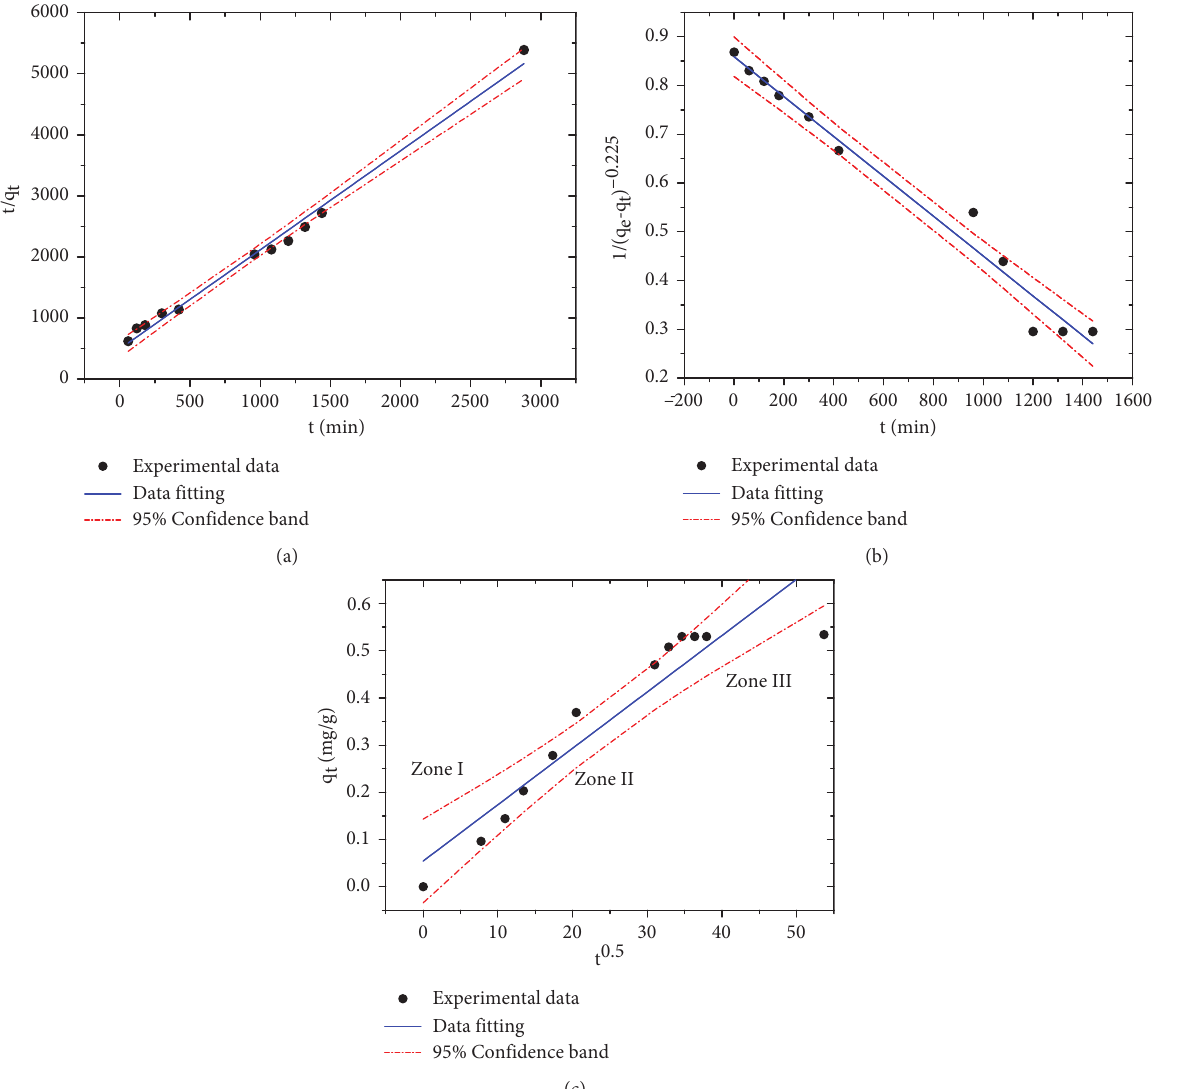
Figure 6: (a) Fitting of experimental data using the pseudo-second-order model. (b) Fitting of experimental data using pseudo-order model ( k n ; n ≠ 1). (c) Fitting of experimental data using intraparticle